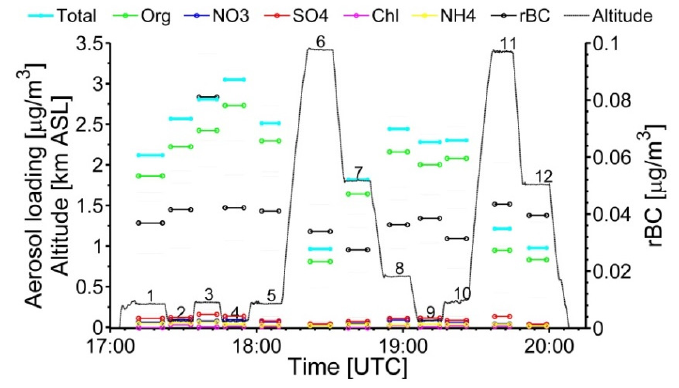
Figure 3. Example of FL-dependent chemical compositions (colored lines) and BC (thick black lines) mass measured by the AMS and SP2, respectively (21 July 2012). Additionally, altitude (thin black line) as a function of FL is included. FLs are labeled with numbers 1 through 12 on top of the thin black altitude